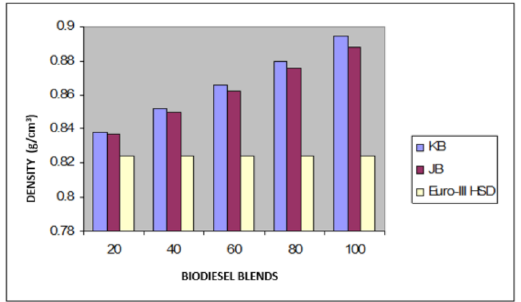
Figure 3. Variation of kinematics viscosity of Jatropha curcus and Pongamia pinnata methyl esters blends with EURO-IV HSD.